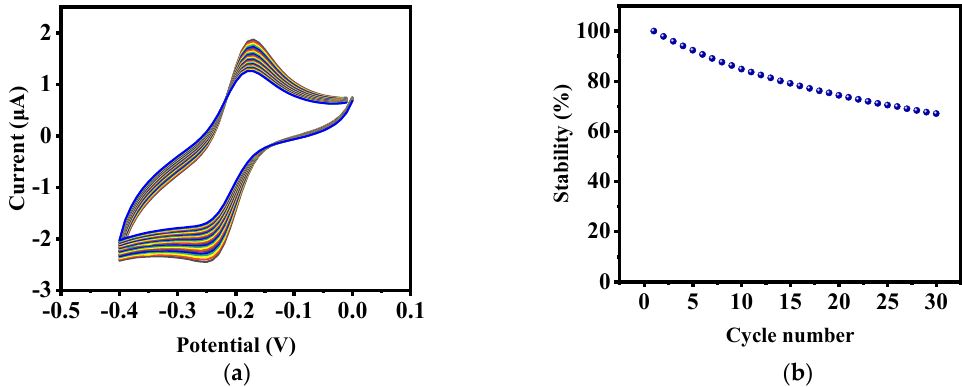
Figure 4. ( a ) Stability test of the electrode labeled by methylene blue. ( b ) Percentage of electrochemical stability of methylene blue electrode.